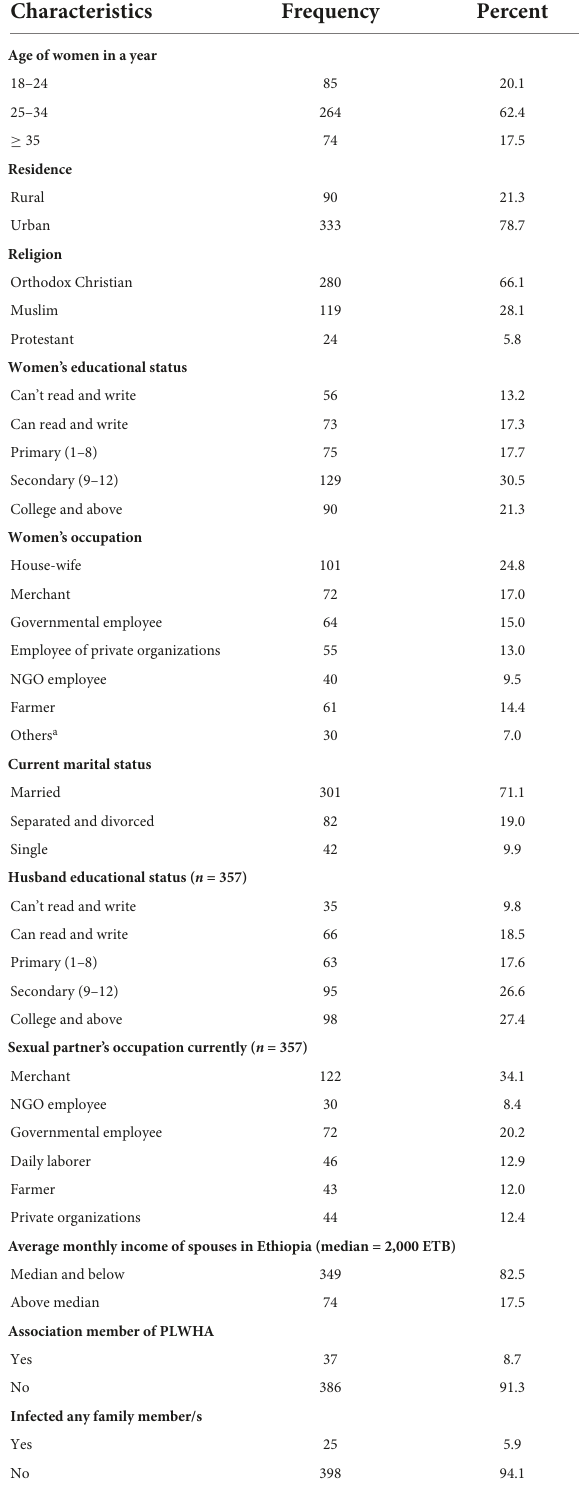
TABLE 1 Sociodemographic-related characteristics of study participants in the Amhara Region Referral Hospitals, Ethiopia, 2020/2021 ( n =